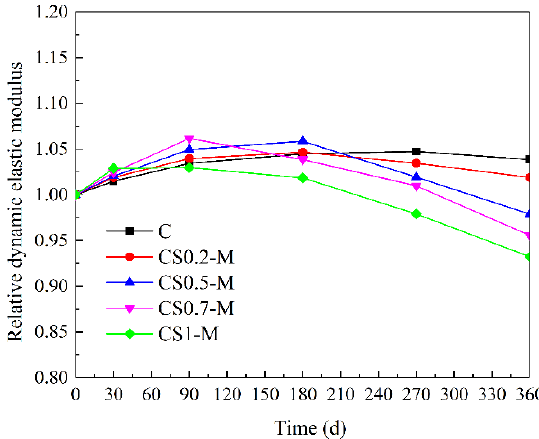
Figure 5. Relative DEM of concrete specimens versus corrosion time.